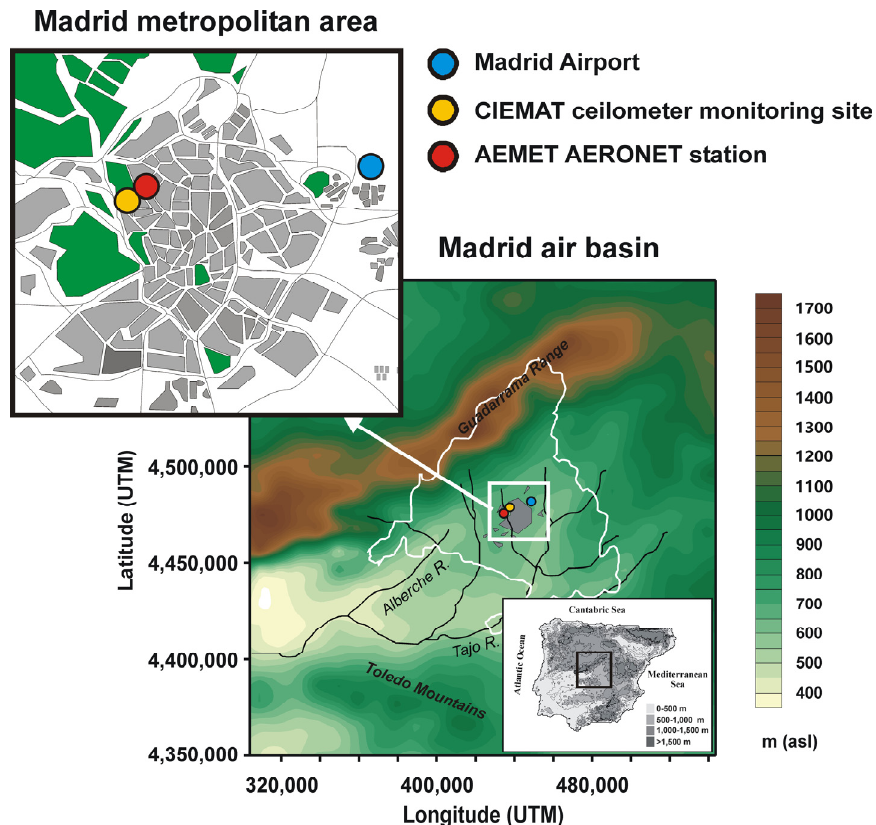
Figure 1. Geographical location of the monitoring site (yellow point), Madrid AERONET station (red point), and the Madrid airport (blue point), where the radiosondes were carried out.